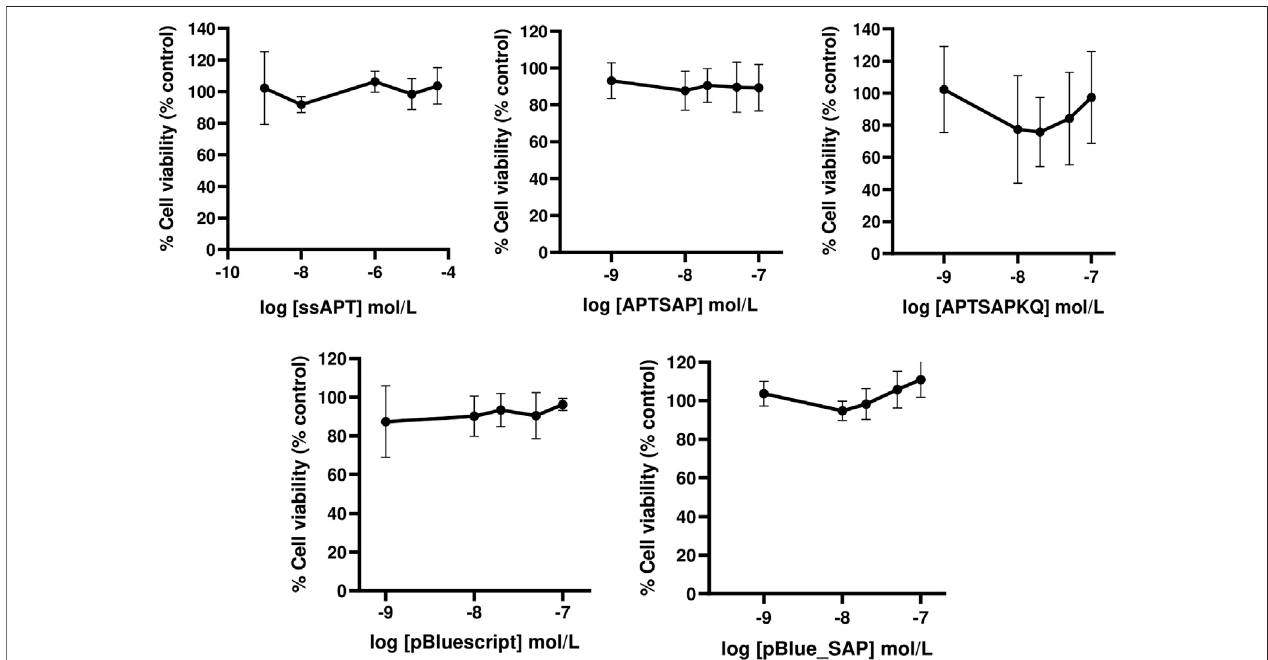
FIGURE 4 | Dose-responsecurves showing respectively the effect of ssAPT, APTSAP, APTSAPKQ, pBlue_SAP and pBluescript II KS (+) on control NIH3T3 cells. Cells(1.6 × 10 3 /well)wereseededin96-wellplatesina fi nalvolumeof200ulofmedium(5%FBS)containingappropriateconcentrations(0,0.001,0.01,1,10,50 μ mol/ L) of ssAPT and appropriate concentrations (0, 0.001, 0.01, 0.02, 0.05 and 0.1 μ mol/L) of APTSAP, APTSAPKQ, pBlue_SAP and pBluescript II KS (+) and for 96 h. All theplasmidsweredenaturedat95 ° Cfor2 minin10 mMTris/HClbufferpH7.5containing100 mMNaCland2.5 mMKClimmediatelybeforeuse.Cellviabilitywas examined using a MTS assay and expressed as percentage of control untreated cell. The data presented are representative of a set of at least three independent experiments and are reported as mean ± SD.